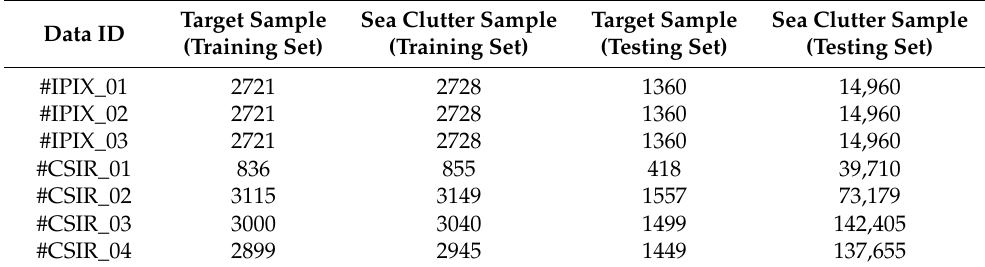
Table 3. Number of training samples and testing samples for different radar data. Radar observation time for each sample is 0.512